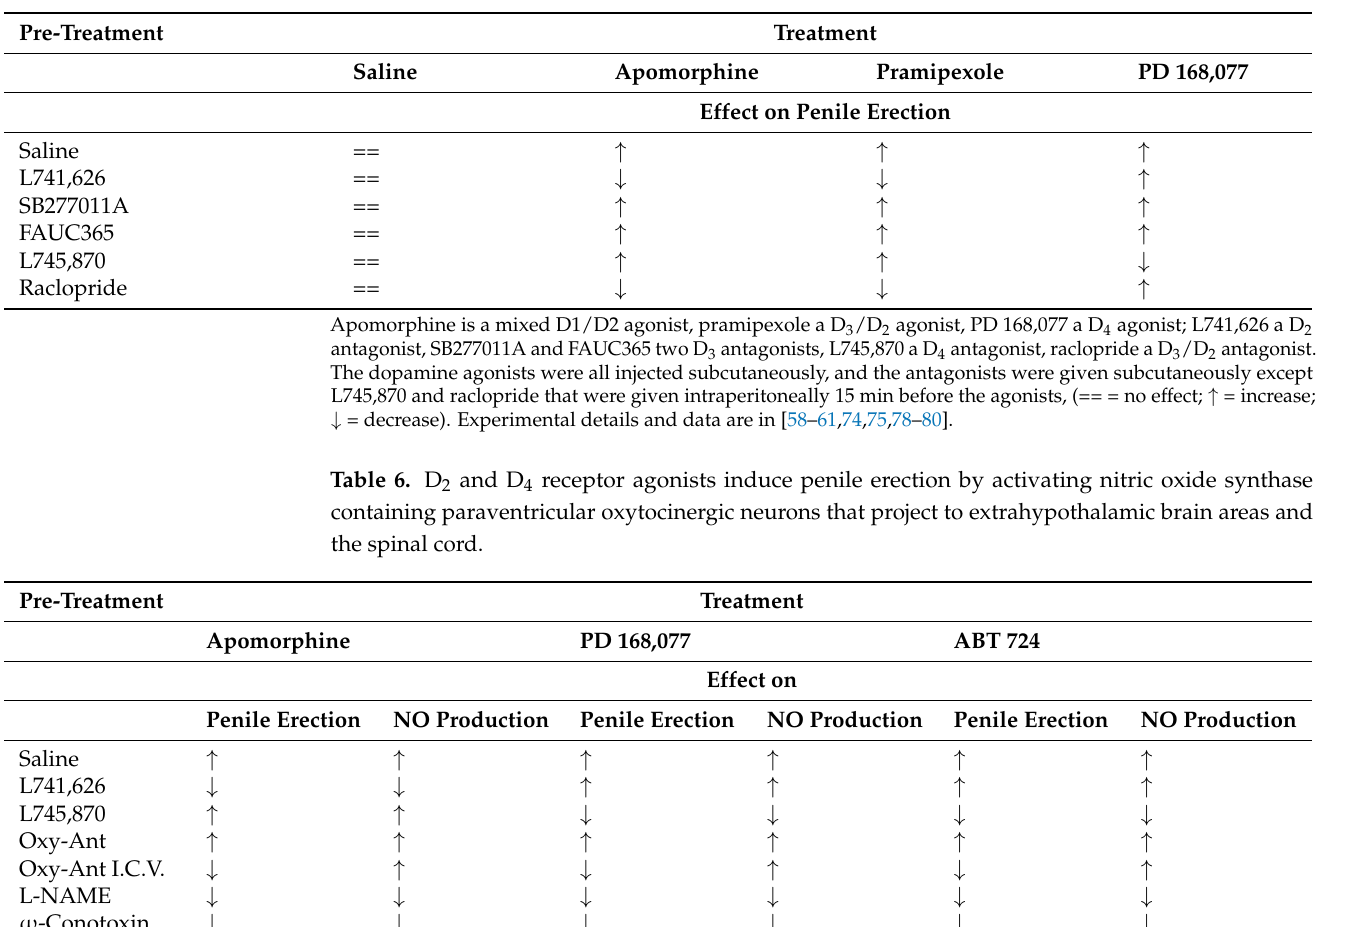
Table 5. D 2 receptors mediate the proerectile effect of the mixed D1/D2 dopamine receptor agonist apomorphine and of the D 3 /D 2 dopamine receptor agonist pramipexole but not of the D 4 dopamine receptor agonist PD 168,077.